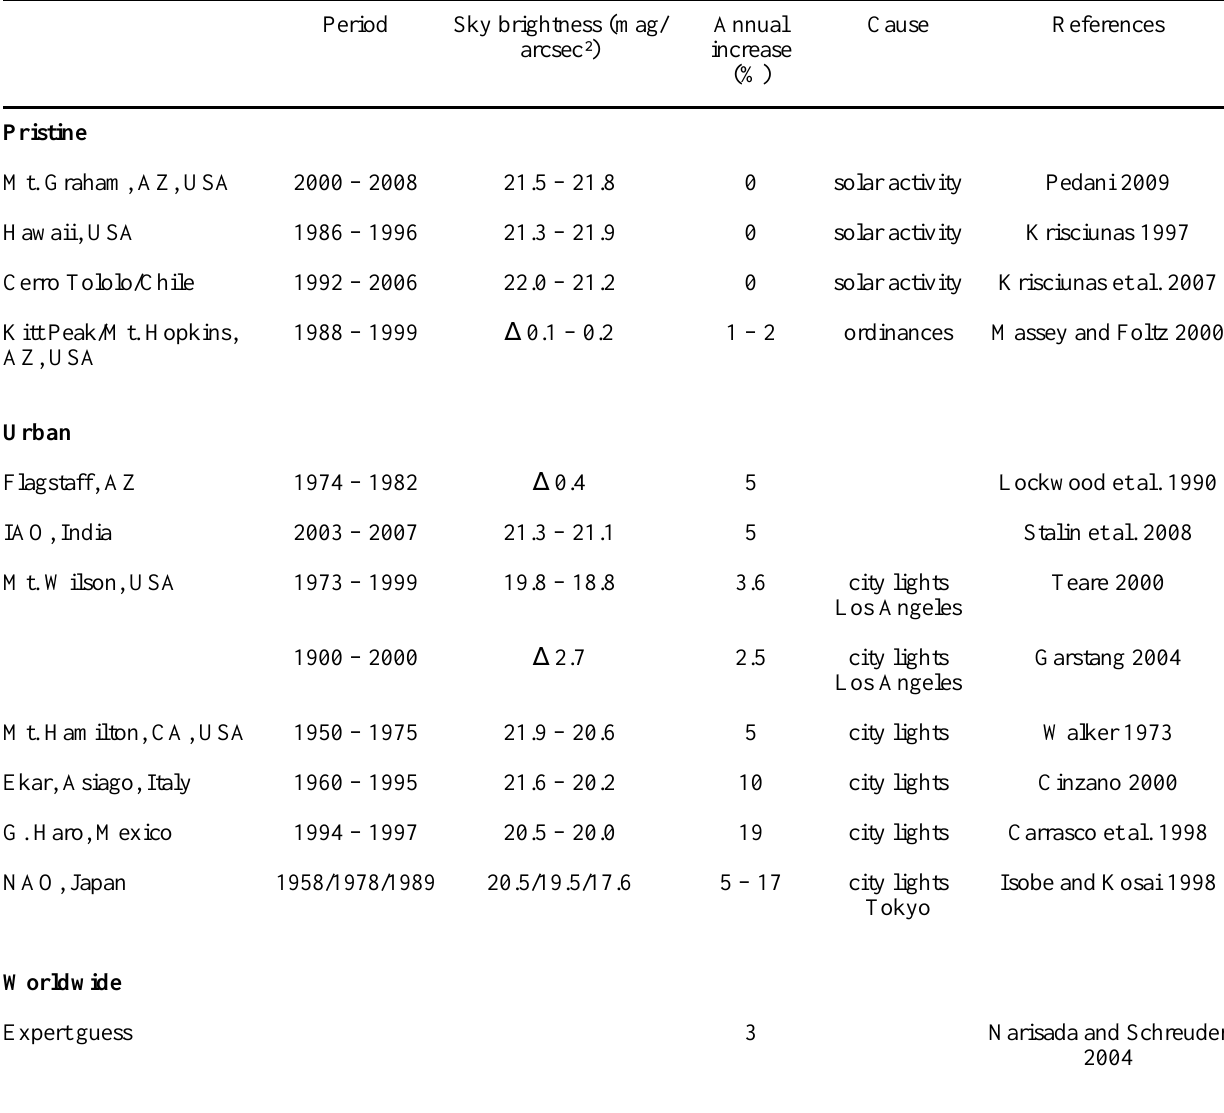
Table 1. Pristine sites with natural sky background brightness can be identified by measuring the sky background (astronomical unit mag/arcsec² in the visual range corresponds to a negative logarithmic scale of sky luminance) at modern astronomical observatories. Older observatories were built at dark sites close to cities. Today, these peri-urban sites are characterized by bright skies. Some observatories in the southwest of the USA were able to preserve relatively dark skies because of lighting ordinances (low pressure sodium lamps, full cut-off luminaires) in the nearby cities, resulting in a decrease of sky brightness in Flagstaff, Arizona since 1982 (Lockwood et al. 1990). The increase of the sky background depends on different model assumptions for several observatories (Garstang 1989). Indirect values can be derived from the increase of power consumption and lamp efficiency for street